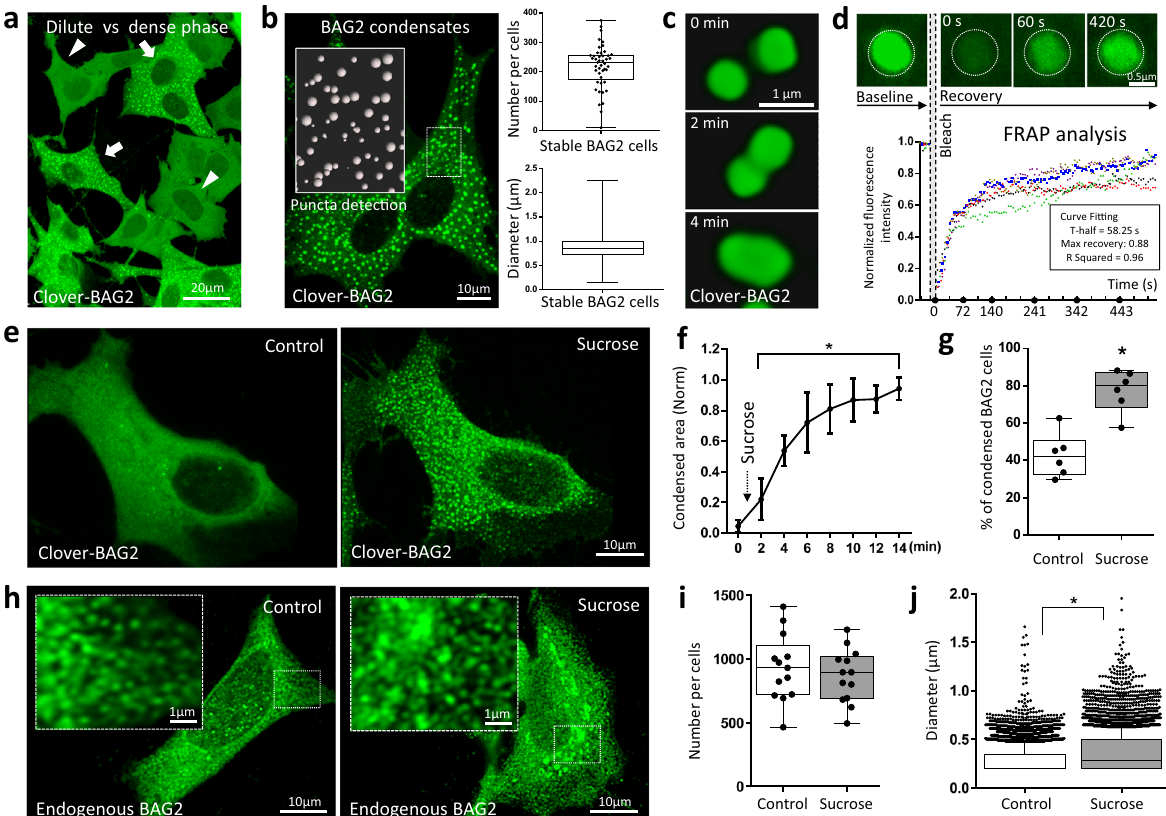
Fig. 1 BAG2 condensation in response to stress. a Representative image of cells expressing BAG2 in both dilute (arrowhead) and dense phases (arrow) in SH-SY5Y cells stably expressing clover-BAG2. 49.7 ± 12.5% of the clover-BAG2 population contained condensates (915 cells, n = 5, mean ± SD). b Representative image of cells containing BAG2 condensates illustrating puncta detection (insert). Number of condensates per cell (45 cells, n = 3); condensate diameter (2798 condensates, 10 cells, n = 3). Box: 25th and 75th percentiles. Line: median. Whiskers: smallest to the largest values. Dots: individual cell. c Image over time (Supplementary Movie 1): fusion of two BAG2 condensates. d Condensates dynamically exchanged BAG2 molecules with the dilute phase as demonstrated by FRAP analysis. Images showing representation of pre-bleaching (baseline), bleaching and post-bleaching fl uorescence recovery; graph: fl uorescence recovery quanti fi cation over time. Colors: different condensates. Insert: Fitting curve mean values for exponential recovery. e Representative image of a clover-BAG2 stable cell before and after stress (Sucrose 125 mM, 15 min). f Quanti fi cation of the total BAG2 condensation area over time. Condensation area is shown as the total sum of clover-BAG2 area normalized by its highest value, * from p = 3 × 10 − 2 (2 min) to p < 1.0 × 10 −